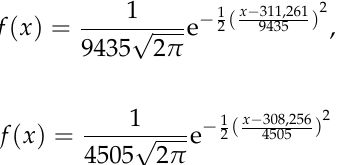
Figure 6. Histogram of values of log𝐿 (cid:3039) (θ) for 𝓀 = 1000 . The probability density function for histogram in Figure 5